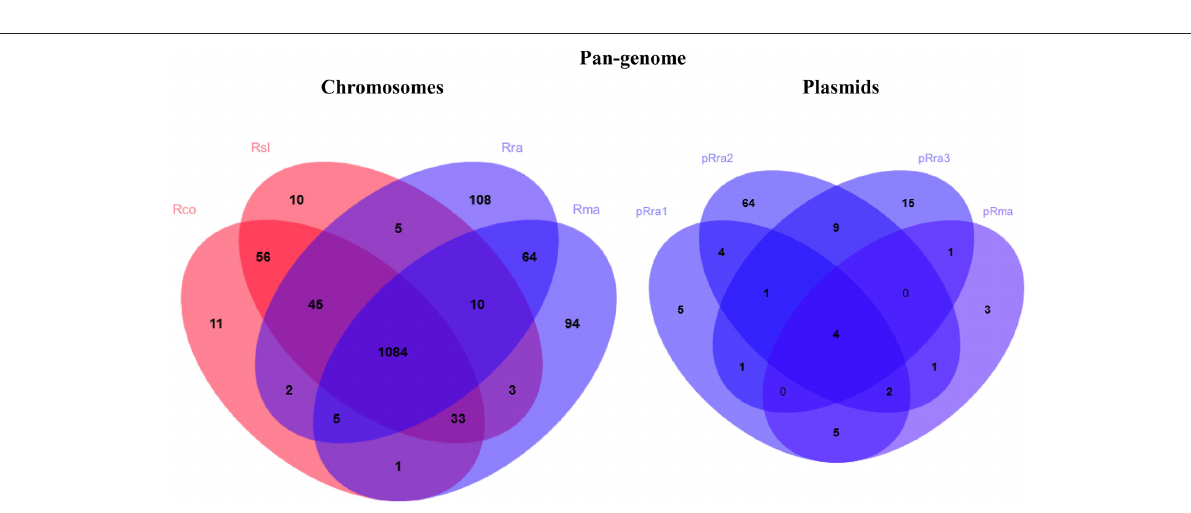
core genes with a high average aa identity and significant low numbers of non-synonymous (NS) mutations and InDels (Rsl vs. Rco: 98%, 3,335 and 933, resp.) when compared with the two milder species (Rra vs. Rma, 96%, 7,888 and 1,495, P ≤ 0.001, χ 2 test, resp.). In the four-way comparisons between one virulent and one milder agent (e.g., Rsl vs. Rra), the conservations in the core genes (average aa identity: 95%) were found to be higher and slightly lower than those obtained between the two virulent agents (98%) and between the two milder agents (96%), respectively. Moreover, the total numbers of NS mutations and InDels observed between one virulent and one milder agent (Rsl vs. Rra: 8,756 and 1,442, resp.; Rsl vs. Rma: 9,126 and 1,659, resp.; Rco vs. Rra: 9,470 and 1,471, resp.; Rco vs. Rma: 9,808 and 1,523) were significantly higher than those found between the